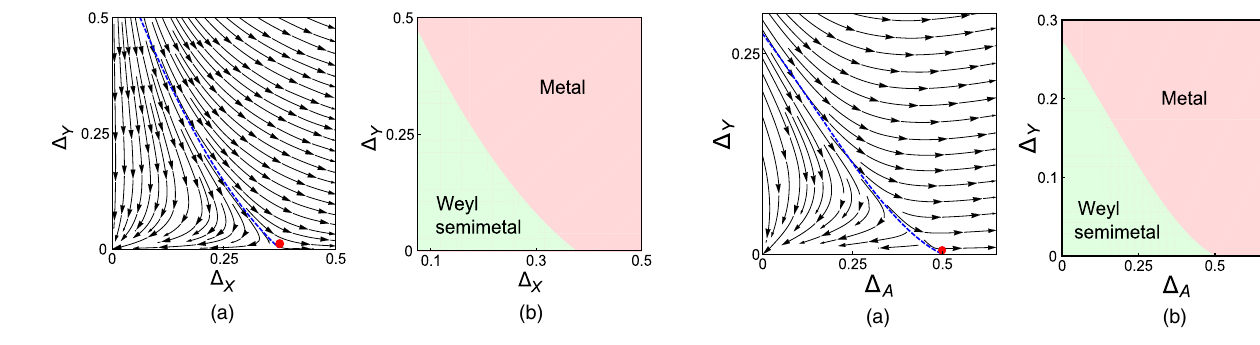
FIG. 12. (a) The renormalization-group flow diagram and − Δ plane, where (b) corresponding phase diagram in the Δ X Y Y ¼ M , C obtained from ϵ 3 ϵ 0 (red dot). The = 8 , Δ one quantum-critical point at Δ X ¼ m Y ¼ phase boundary between the Weyl semimetal and metal in (b) is determined by the irrelevant direction, shown by the blue dotted line in (a). These figures are qualitatively similar to the ones shown in Fig. 11, apart from the nonuniversal shift in the phase